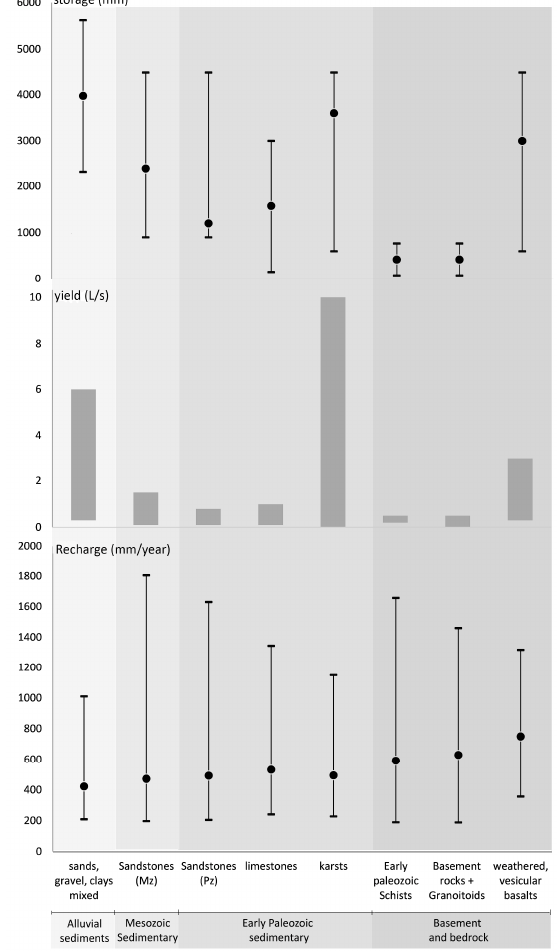
Figure 4. Overview of the hydrogeological indicators in Laos. Storage (min–max and average) is in mm, considering a 30 m saturated aquifer thickness; borewell yields range in L/s and minimum, maximum and average annual recharge in mm (recharge data source: [33]).